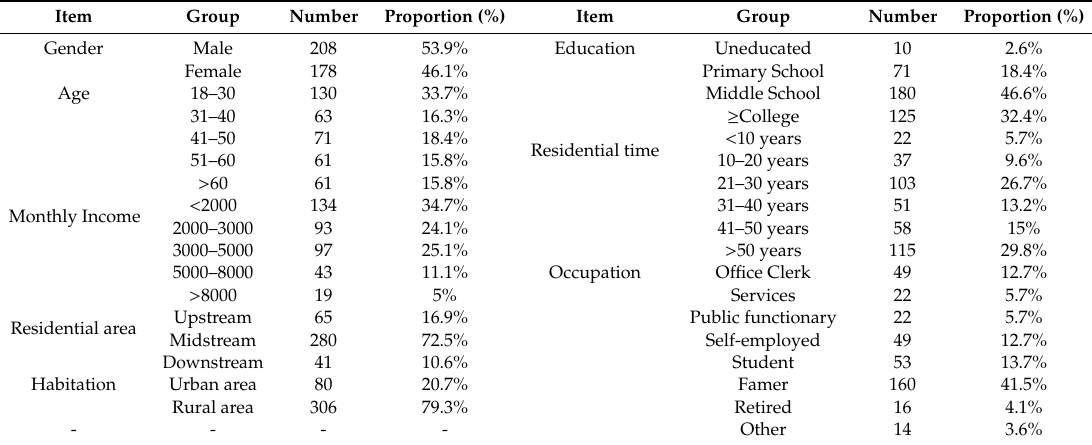
Table A1. Basic information of respondents.